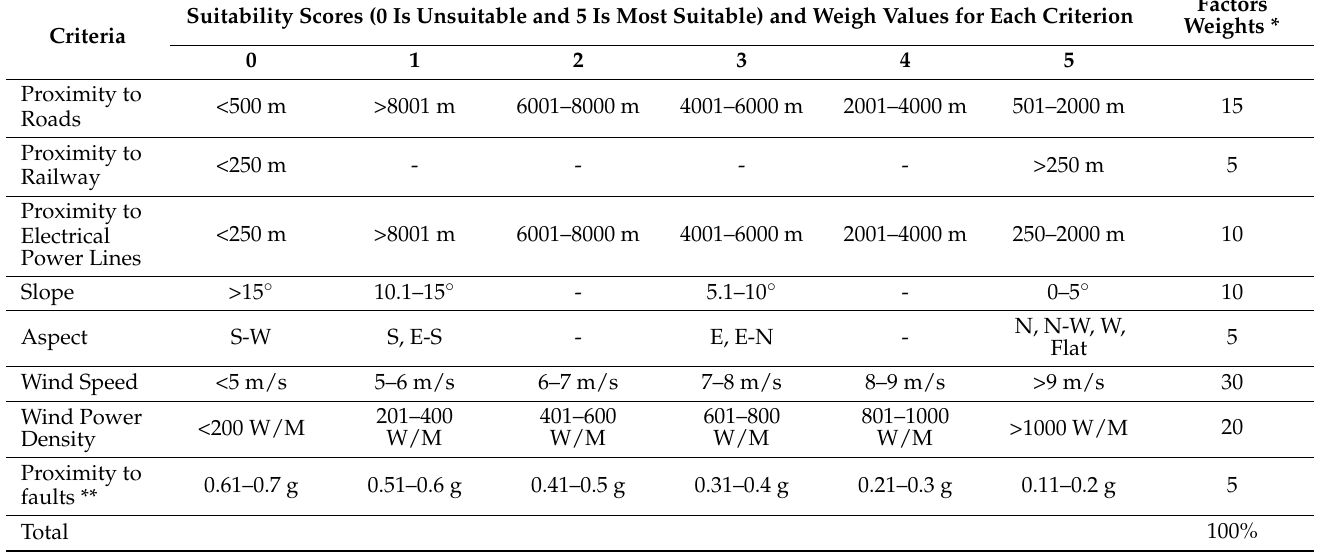
Table 2. Factors used to determine suitability for wind farm locations considering environmental and geospatial data goals.